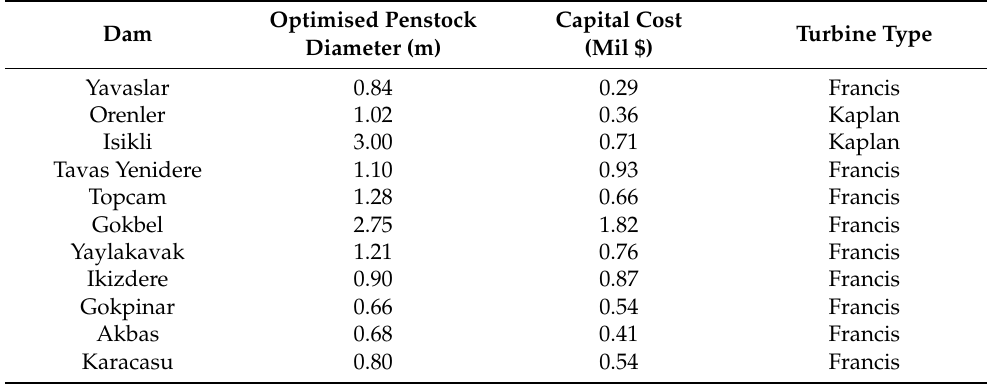
Table 4. Optimized Penstock Diameter, Capital Cost, and Turbine Type for the